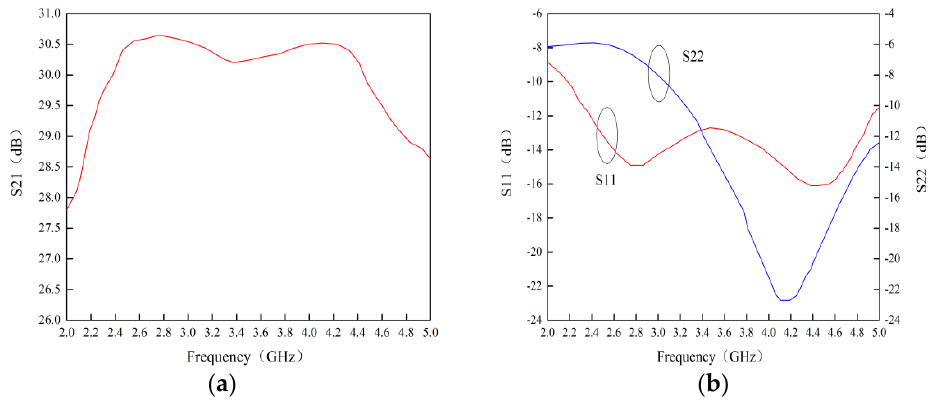
Figure 3. Simulated curves of S-parameters: ( a ) S21; ( b ) S11 and S22.